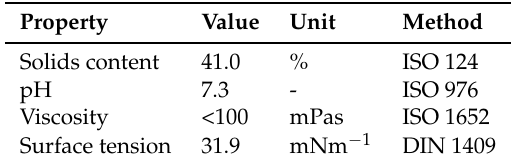
Table 1. Physical properties of Litex®N2890